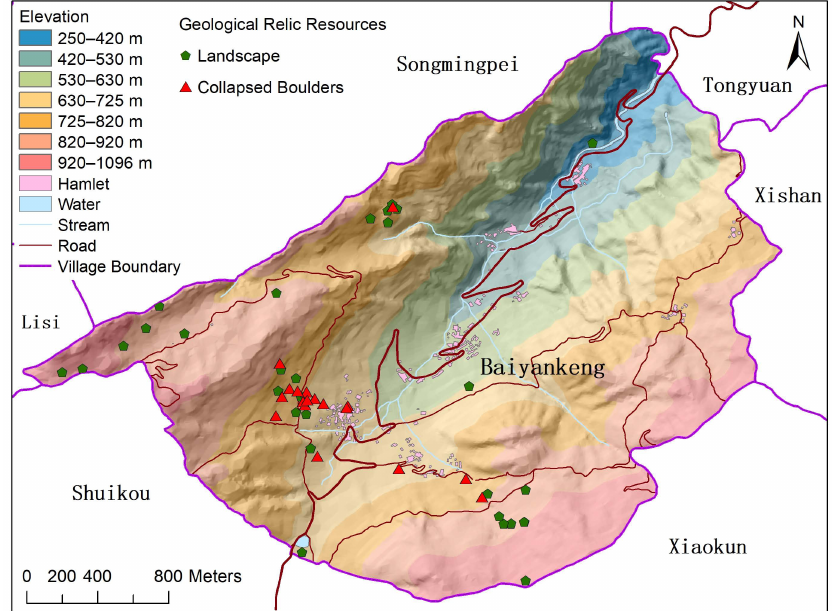
Figure 2. The DEM (5 m, 2013) and the distribution of geological relics in Baiyankeng village (the DEM and attribute database of the village were collected from the former Bureau of Surveying, Mapping and Geographic Information of Zhejiang Province, and the point data of the distribution of geological relics were obtained from Ref.